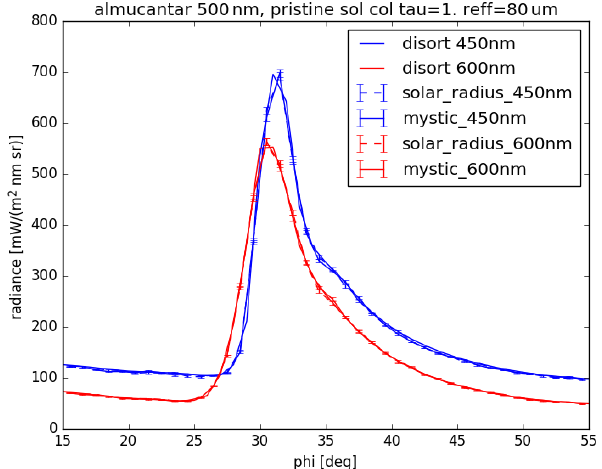
Figure A1. Comparison between MYSTIC (lines with error bars) and DISORT (solid lines) for the region of the 22 ◦ halo for red (600nm) and blue (450nm) light. For the MYSTIC simulations, the effect of taking the solar radius into account (dashed lines with error bars) vs. assuming a point source (solid lines with error bars) is shown as well: 10 5 photons are used for the MYSTIC simulations and 16 streams for DISORT. For all simulations a solar zenith angle of 50 ◦ is assumed, and the halo slice is computed in the almucantar plane, i.e., with a varying azimuth and a constant solar zenith angle. The ice cloud was defined with an optical thickness of 1 and consists of smooth solid columns with an effective radius of